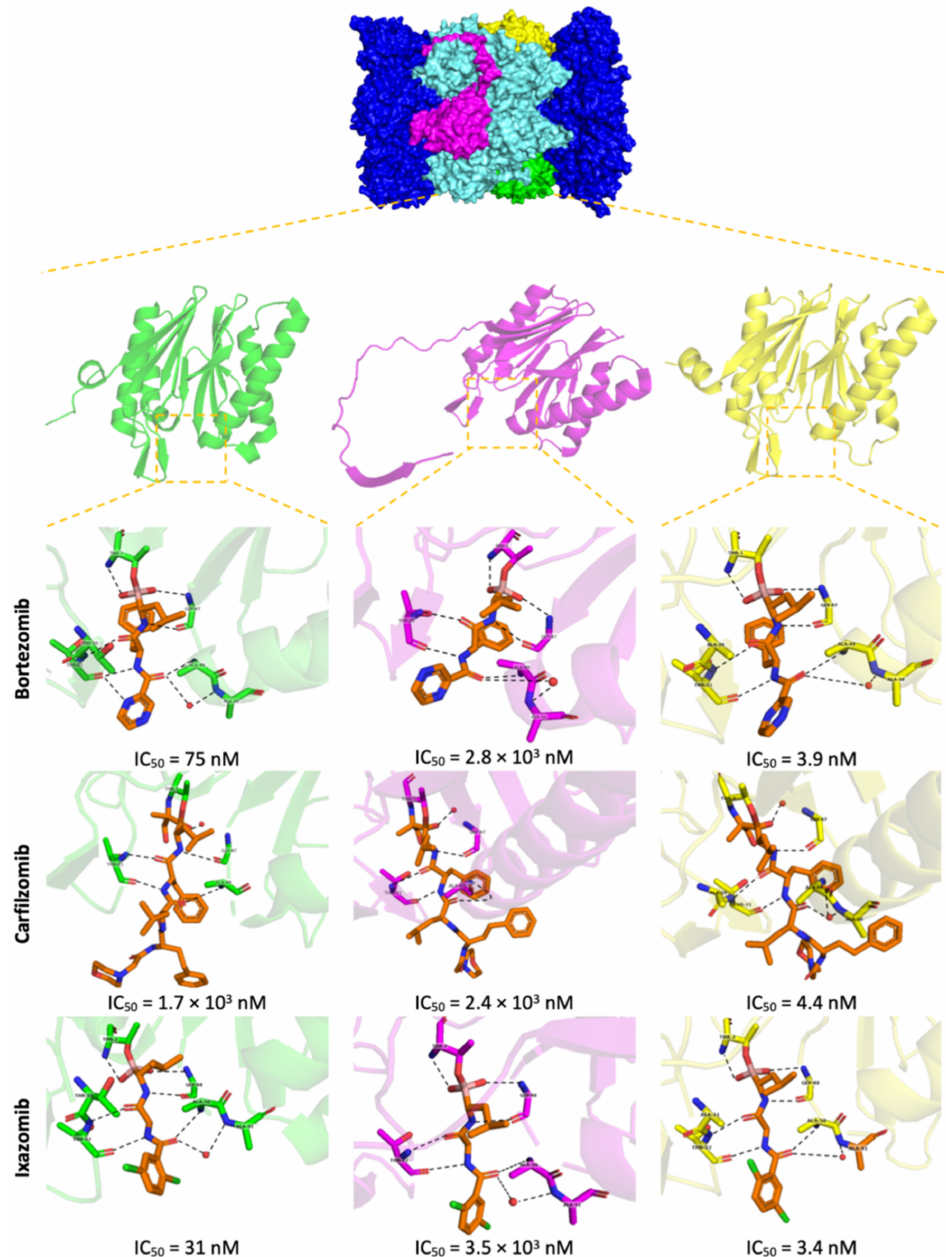
Figure 5. Three β catalytic subunits of 20S CP complexed or not with the three approved inhibitors. The β 1, β 2, and β 5 subunits are colored in green, magenta, and yellow, respectively. The inhibitors are colored in orange; hydrogen bonds are shown as black dashed lines and water molecules are represented as red spheres. These images were generated with the crystallographic structures whose PDB IDs are 4R67, 5LE5, 5LF3, and 5LF7. Source: Report RPT-01200 Amendment 2 and Study